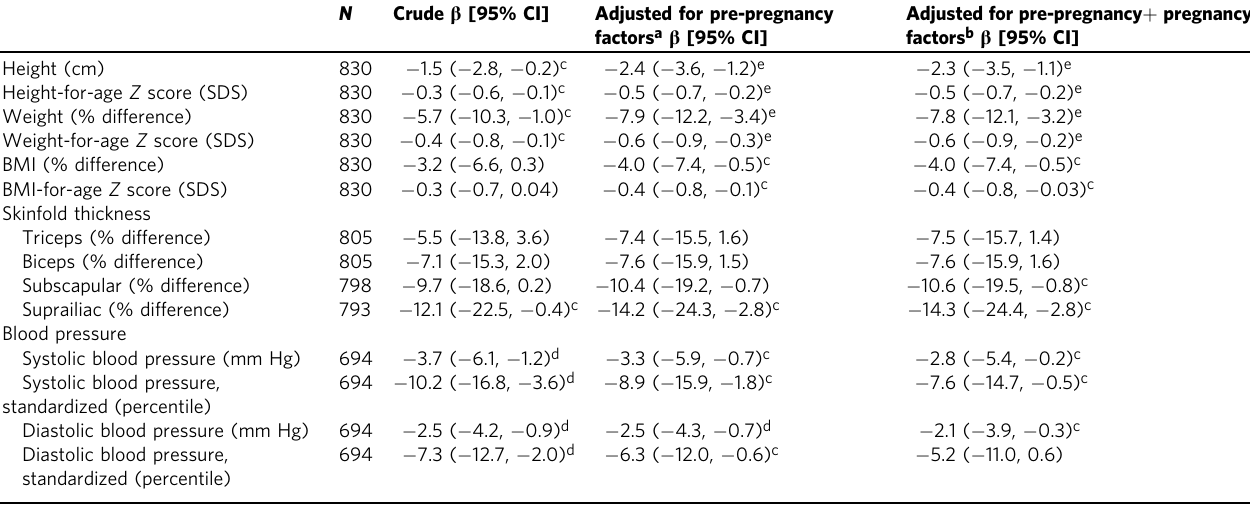
Table 2 Child anthropometrics, skinfolds, and blood pressure at 6 years, adjusted for pre-pregnancy and pregnancy factors. N Crude β [95%